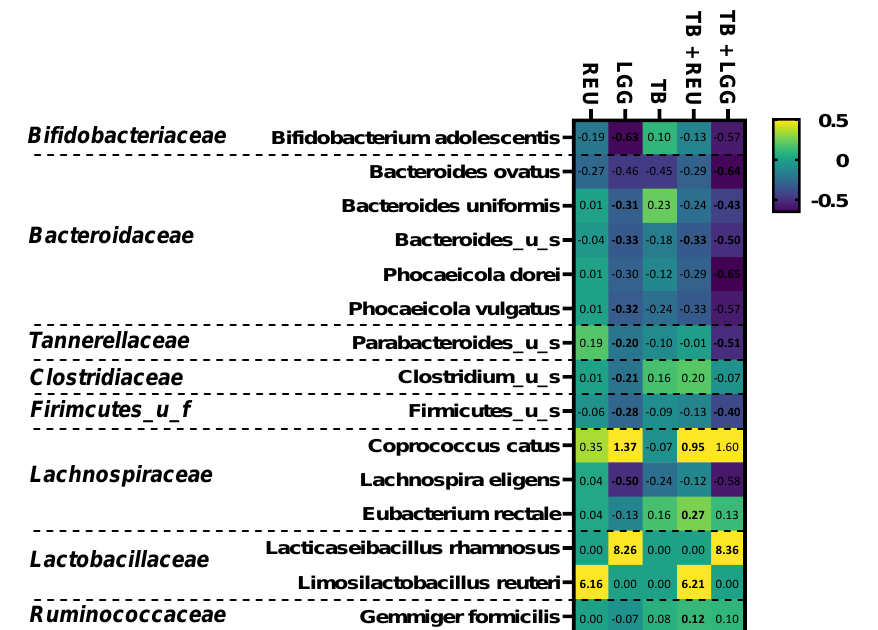
Figure 5. The impact of two Lactobacillaceae species (LGG and REU), tributyrin oil (TB), and combinations thereof on microbial species (belonging to specific families) that were significantly affected by any of the treatments compared to an untreated NSC (FDR = 0.20). Values are expressed as log 2 (abundance treatment/abundance NSC), as averaged over simulations for six human adults using the SIFR ® technology platform. Samples were collected at 48 h after initiation of the colonic incubations. Significant differences are indicated in bold.